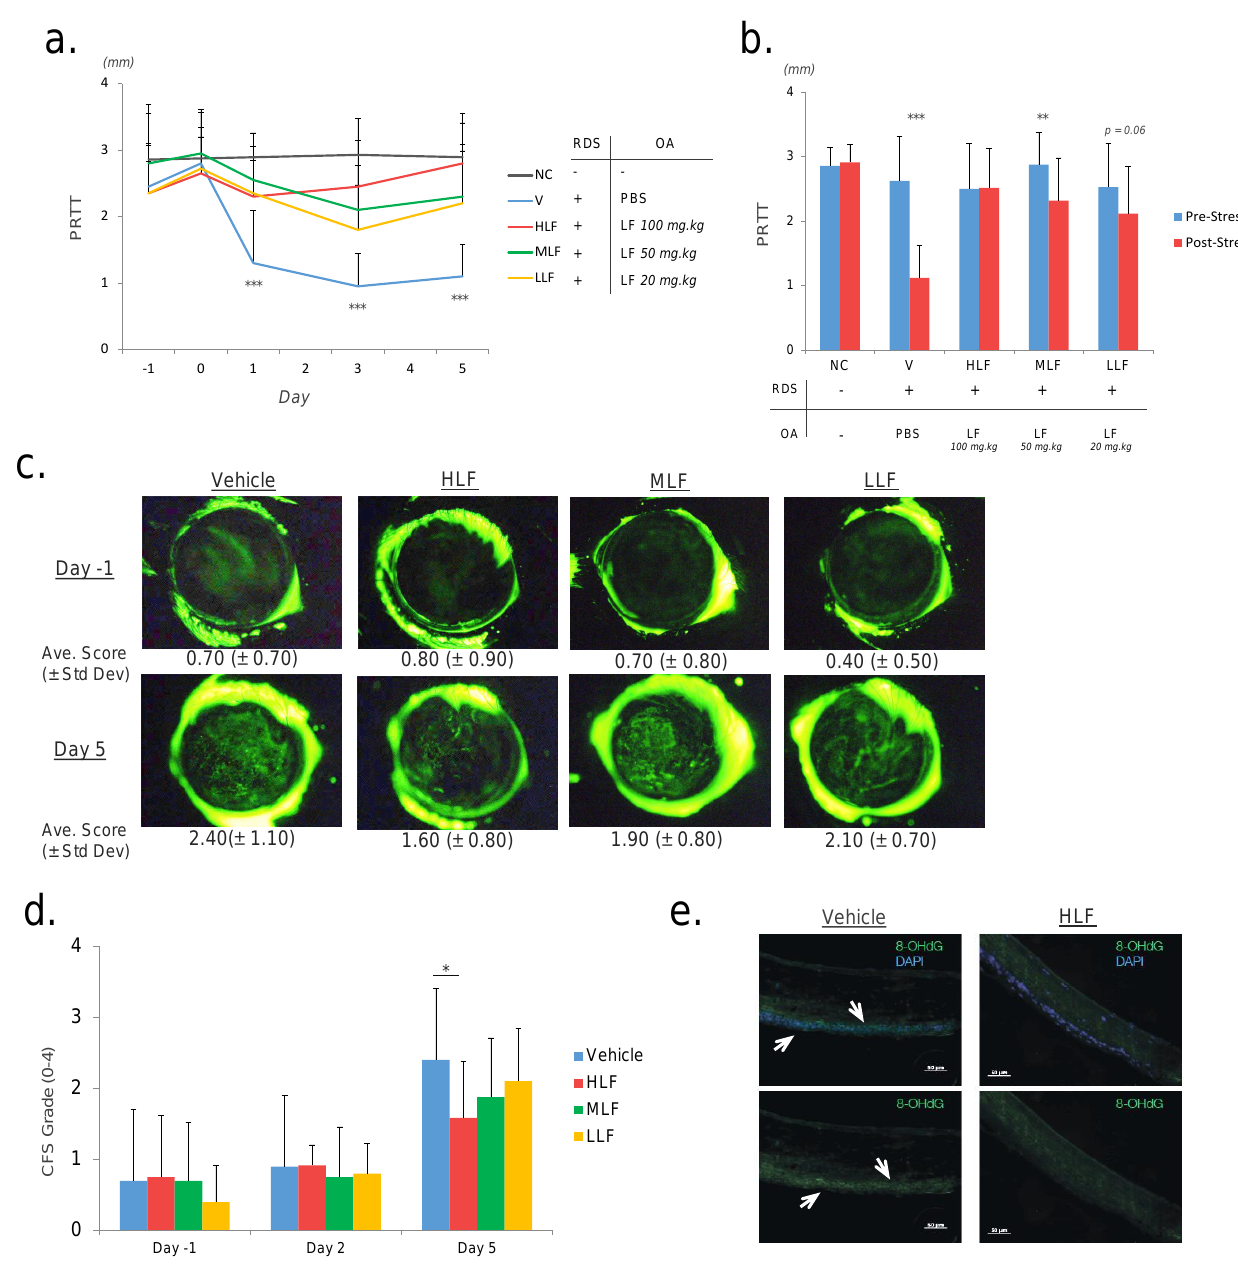
Figure 1. Protection of tear secretion by oral administration of lactoferrin. ( a ). Phenol red thread test (PRTT) results showing the rapid and significant decline in PRTT measurement in V mice after the initial stress event at day 0, whereas the LF administered mice maintained a measurement close to that of pre-stress levels with HLF showing the greatest results. The prolonged hyposecretion in V mice can be easily observed for the remainder of the protocol. ( b ) Bar chart highlighting the pre (day -1 and 0) and post (day 1 to day 5) initial stress event differences in PRTT results. ( c ) Comparison of typical images of corneal fluorescein staining on day 1 and day 5. HLF mice showed a significant reduction in ocular surface damage. ( d ) Average corneal fluorescein staining scores at day 1, 2, and 5. ( e ) Immunofluorescence staining for the oxidative damage marker, 8-OHdG. Positive staining is highlighted by arrows. Positive staining was observed in fewer cells in the corneal epithelium of HLF mice, indicating a reduction in oxidative stress induced